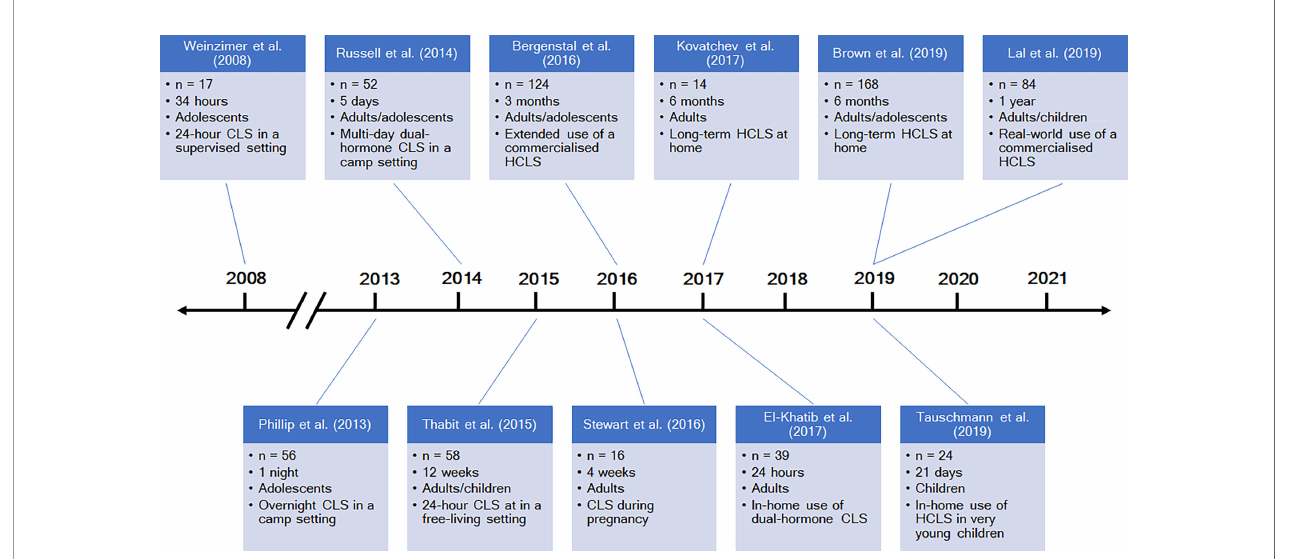
FIGURE 4 | A timeline of selected studies of closed-loop systems. CLS = closed-loop system; HCLS = hybrid closed-loop system. References: Weinzimer et al., (24), Phillip et al., (42), Russell et al., (43), Thabit et al., (26), Bergenstal et al., (27), Stewart et al., (44), Kovatchev et al., (45), El-Khatib et al., (46), Brown et al., (47), Tauschmann et al., (48), Lal et al.,